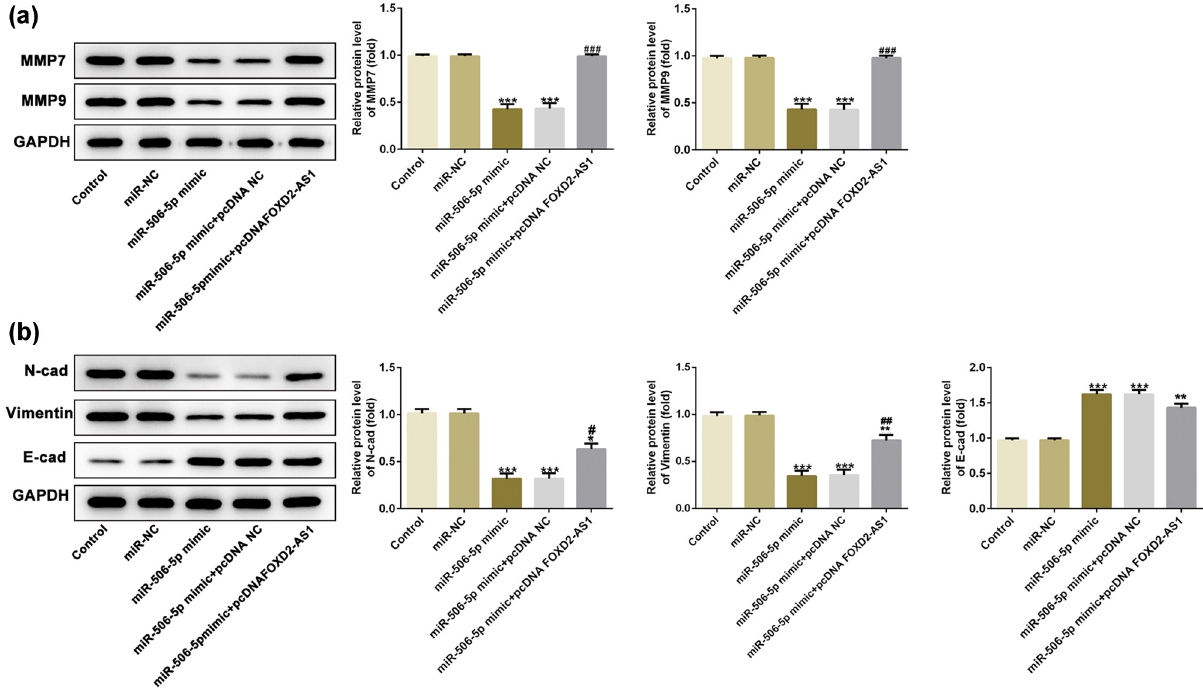
Figure 5: FOXD2 - AS1 promoted invasiveness and EMT in U251 cells via regulating miR - 506 - 5p. ( a ) miR - 506 - 5p mimic decreased the expression of invasiveness - related proteins MMP7 and MMP9 in U251 cells as determined using a western blot assay, which could be abolished by pcDNA - FOXD2 - AS1. ( b ) Overexpression of miR - 506 - 5p reduced the expressions of N - cad and vimentin in U251 cells, while FOXD2 - AS1 upregulation could abolish the e ff ects. pcDNA - FOXD2 - AS reduced E - cad expression in U251 cells transfected with the miR - 506 - 5p mimic but its in fl uence di ff ered slightly from that of miR - 506 - 5p mimic and miR - 506 - 5p mimic + pcDNA - NC groups. N = 5, * P < 0.05, ** P < 0.01 and *** P < 0.001 vs. miR - NC and control; # P < 0.05, ## P < 0.01 and ### P < 0.001 vs. miR - 506 - 5p mimic and miR - 506 - 5p mimic + pcDNA -